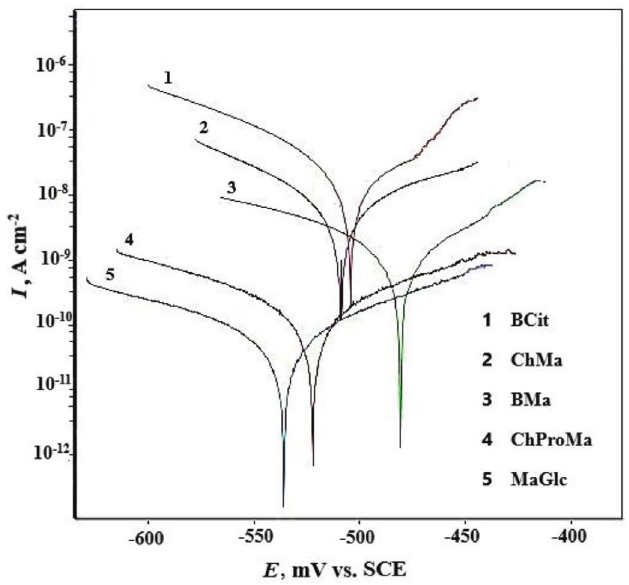
Fig. 7 – Potentiodynamic polarization curves obtained for steel X6CrNiTi18-10 in NADES with 50 % (w/w) water at 25 °C